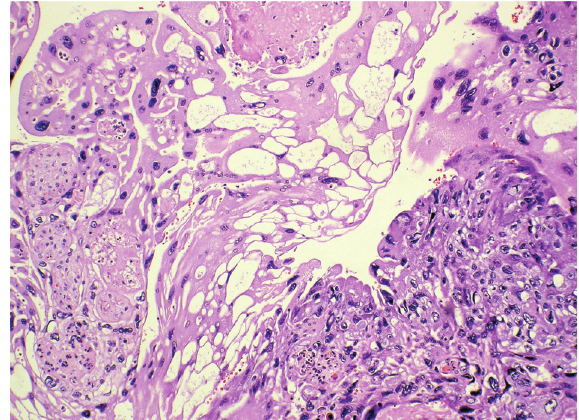
Figure 2: Biphasic tumor tissue with neoplastic syncytiotro- phoblast to the left and neoplastic cytotrophoblast to the right (H&E ×